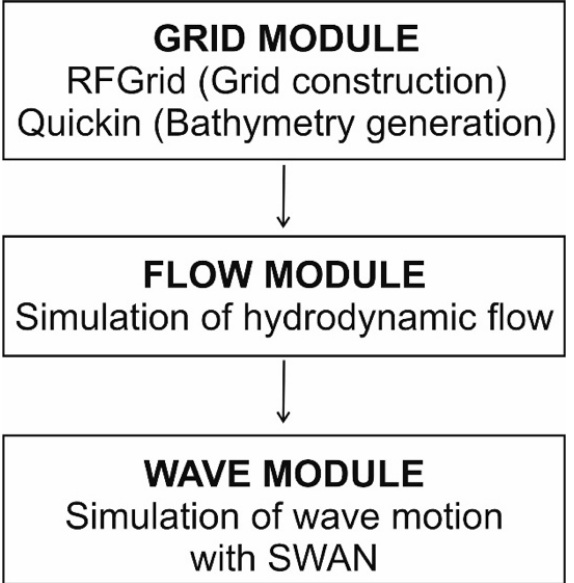
Figure 7. Flow chart of the processing steps followed in the application of Delft3D software .